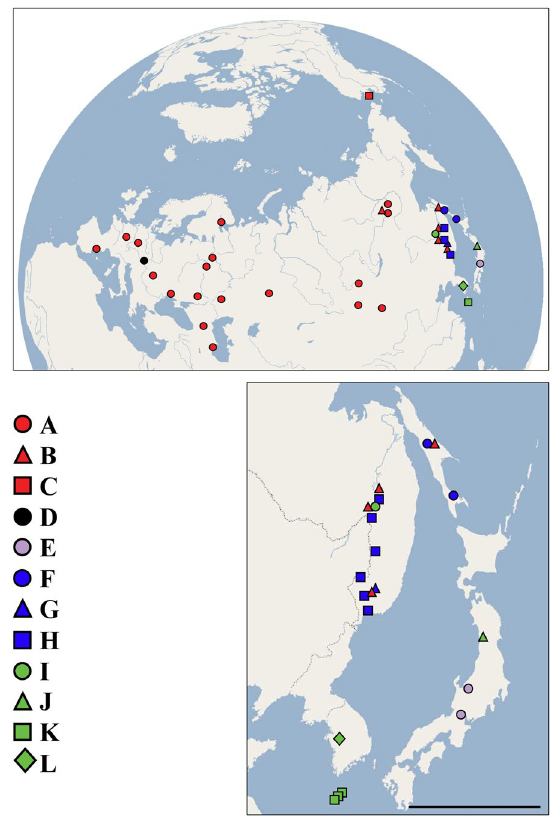
Figure 1. All sites from which diversity of the Daphnia curvirostris group has been analyzed ( a ), and a region of the group maximum diversity — Far East ( b ). The base map is the Marble Virtual Globe 1.5.1 “plain map” (i.e., no attributable data layers) available at https://marble.kde.org/.